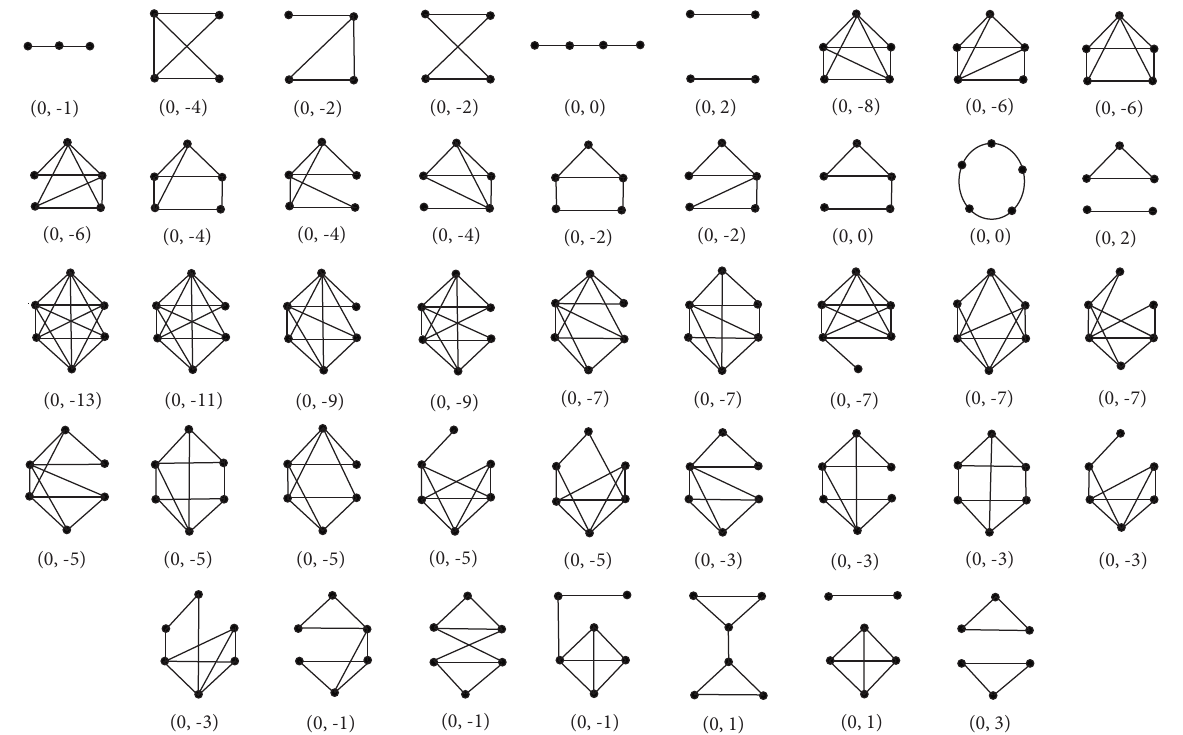
Figure 1: Quasi f -graphs up to n ≤